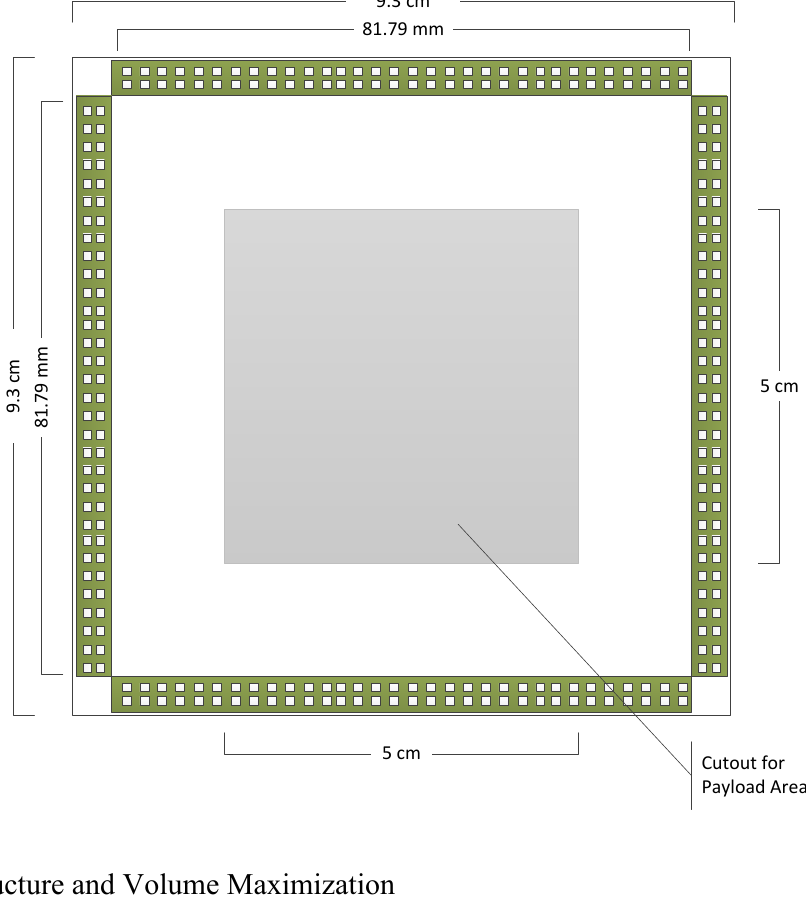
Figure 14. Receiver (bottom face) plate for OPEN board